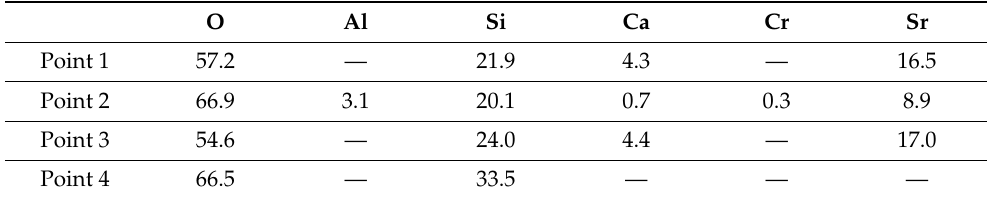
Table 4. EDS point analyses (at.%) performed on HJ14 glass-ceramic bonded to positively polarized Crofer22APU on the air side (analysis corresponds to Figure 6).